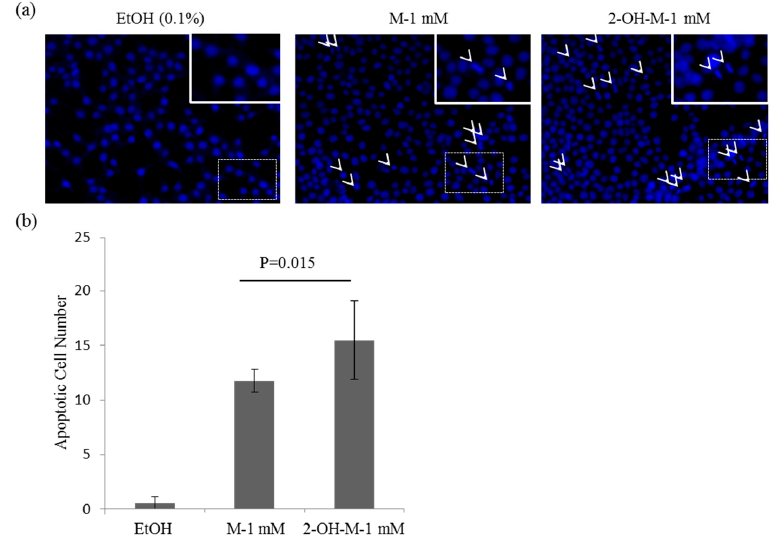
Figure 2. Induction of nuclear condensation in Caco2 cells by melatonin or 2-hydroxymelatonin. ( a ) Hoechst 33258 staining of Caco2 cells treated with melatonin or 2-hydroxymelatonin dissolved in ethanol. Arrows indicate cells with condensed or fragmented nuclei. Representative images from three independent experiments are shown. Enlarged images are shown in the top right inset of the image; ( b ) Quantification of condensed or fragmented nuclei in cells treated with melatonin or 2-hydroxymelatonin. Data represent mean ± standard error of the mean, n = 3. EtOH, ethanol; M, melatonin; 2-OH-M, 2-hydroxymelatonin.